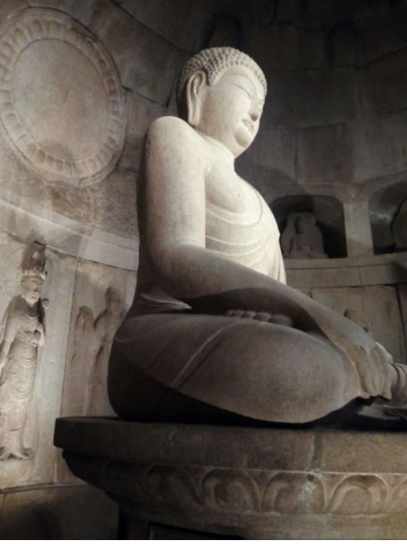
Figure 21. A view of inner tranquility at the central chamber of